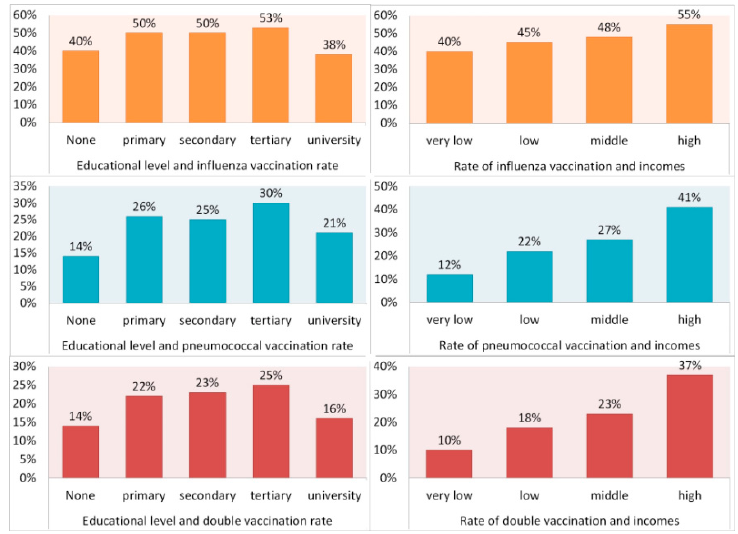
Figure 2. Relation between educational and economic levels and immunization rates. In a multivariate analysis, after adjustment for the factors found in the bivariate model and the exploratory socio-demographic analysis, the stronger predictors of vac- cines rates in all groups were the geographic zone (Southern cone having the highest odds), age (approximately 3% increase per aging year), and income level (Table 3), both for IV and PV. Heart failure was associated with IV only, and diabetes was not associated with IV or PV after Bonferroni’s adjusted p -value. Smoking was an independent predictor of non-vaccination for IV and PV. Table 3. Multivariate analysis, independent predictors of Influenza vaccination and Pneumococcal vaccination. Independent Predictors of Influenza Vaccination, Full Cohort (n = 4216) Term